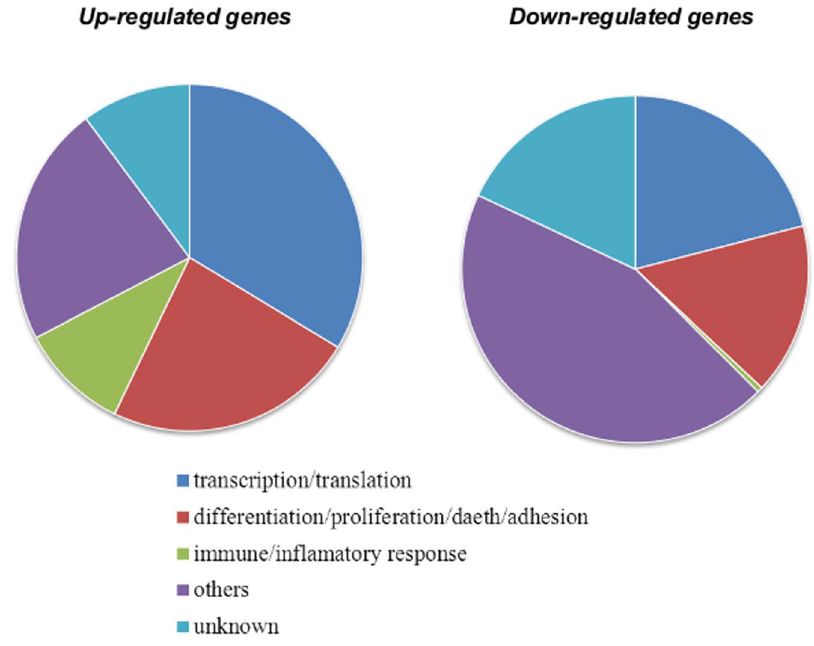
Figure 5. Distribution of up- and down- regulated [Na + ] i /[K + ] i -sensitive genes listed in Tables 2 and 3 among major functional categories.